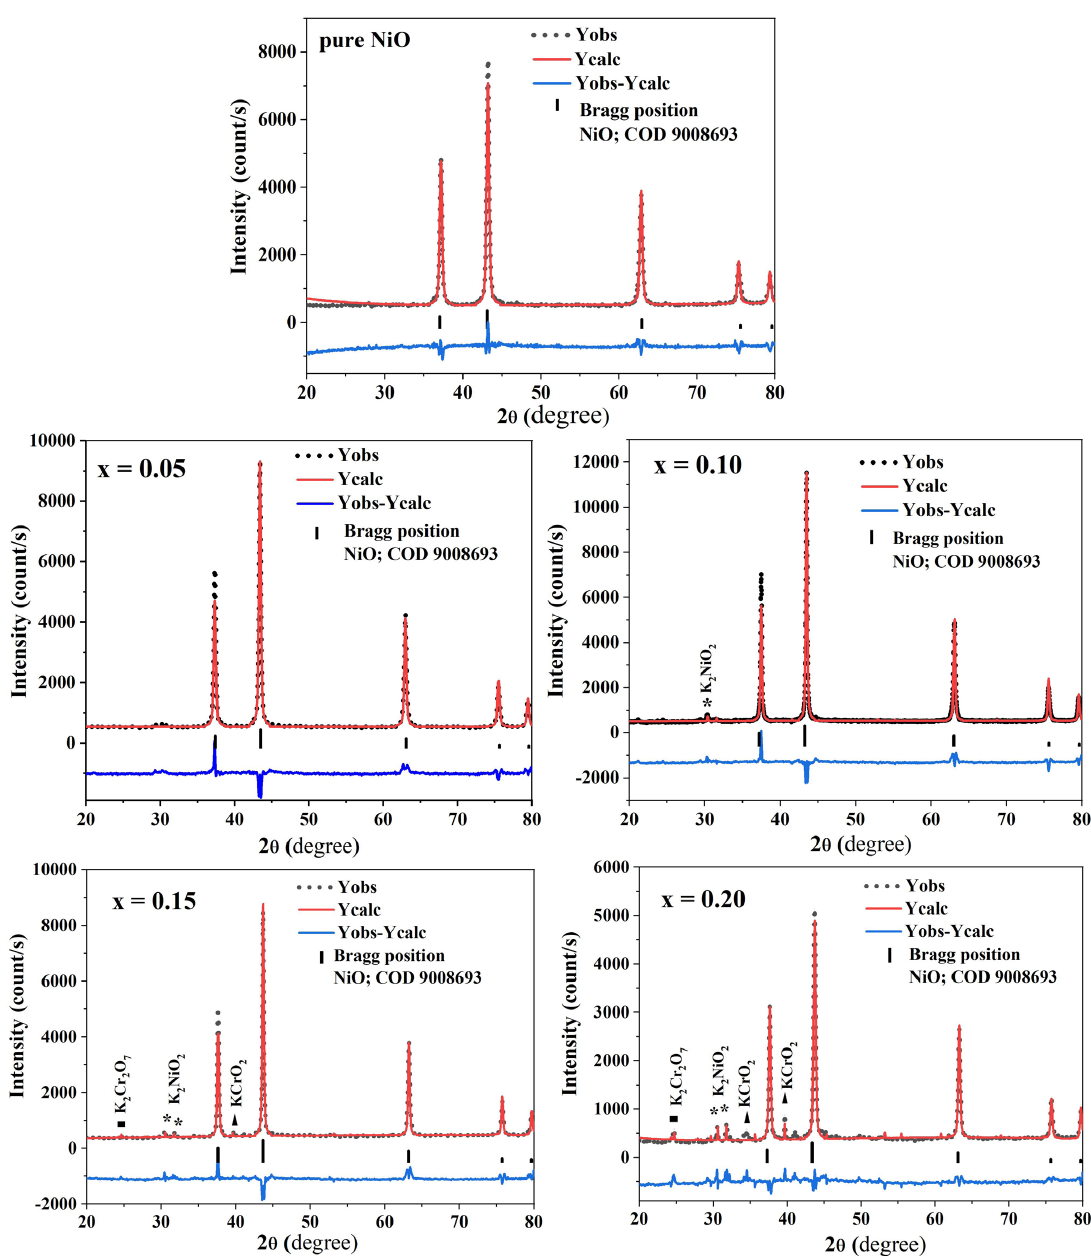
Figure 2. Rietveld refined parameters of pure NiO and samples with various K concentrations. The dotted symbols represent the observed data points and the red solid line is calculated Rietveld refined data. The vertical black tick marks indicate the position of the Bragg reflections of the cubic NiO phase and the blue solid line at the bottom reveals the difference between the observed data points and the calculated data. It can be seen that all samples could be fitted to the cubic NiO structure within the Fm-3m space group (COD database code: 9008693). All XRD patterns of the cubic NiO structure are nearly identical